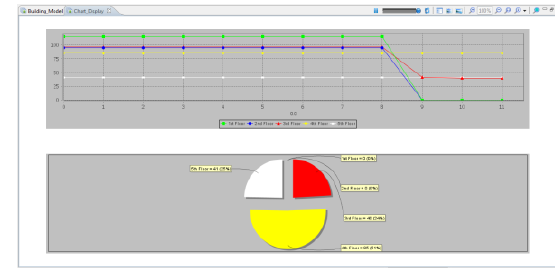
Figure 8. A screen capture image of the PEOPLE agents population chart at time = 11 seconds